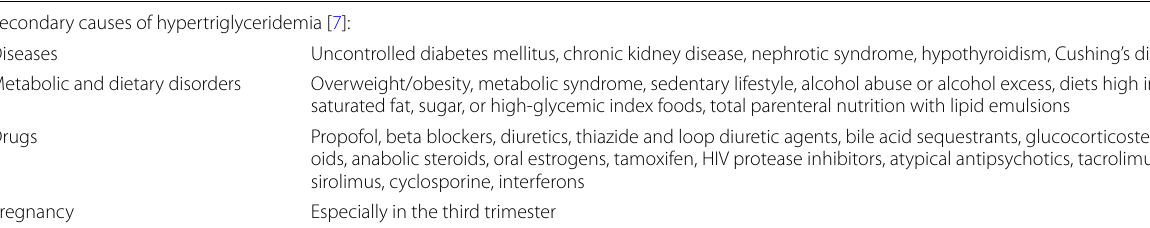
Table 2 Secondary causes of hypertriglyceridemia Secondary causes of hypertriglyceridemia [7]: Diseases